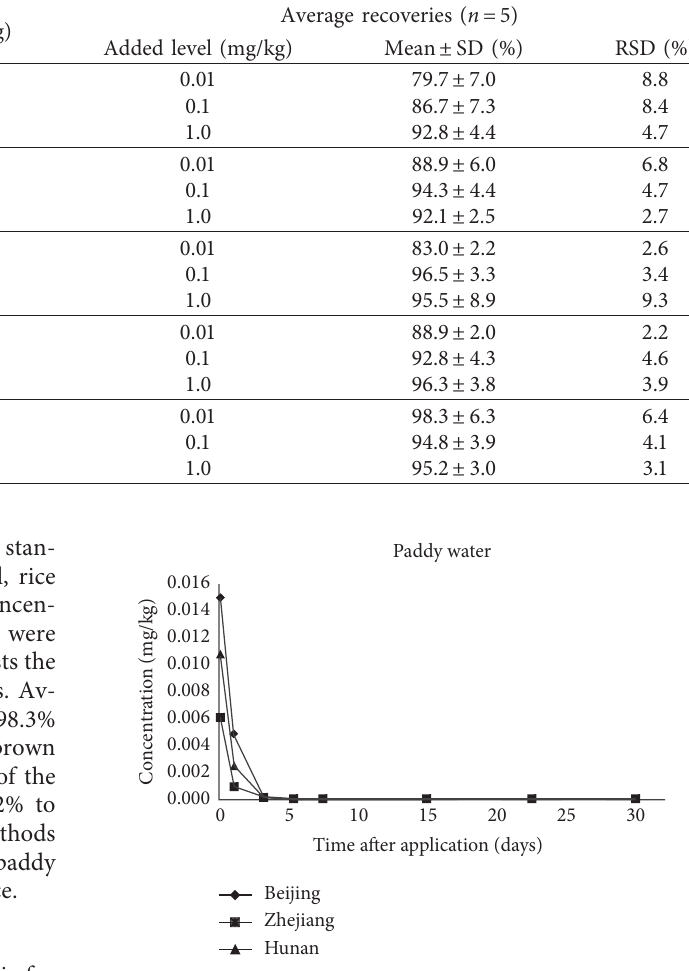
Figure 1: Dissipations of indoxacarb in paddy water in Beijing, Hunan, and